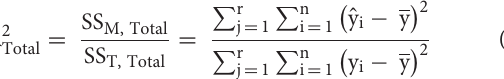
Avg k refer to lagged and moving average predictors,